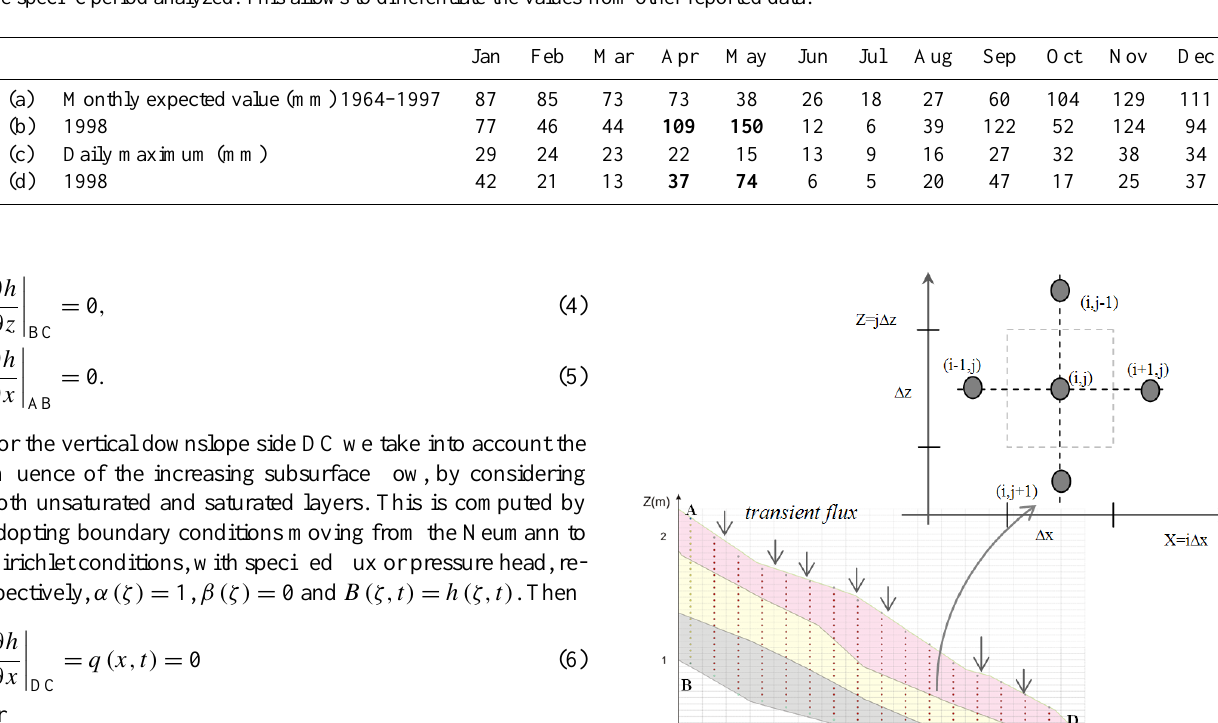
Table 2. Comparison between mean monthly rainfall computed for the period 1964–1997 and the year 1998 (rows a–b); and between maximum daily rainfall for the period 1964–1997 and the year 1998 (rows c–d). Some values are in bold because they reflect the situation of the specific period analyzed. This allows to differentiate the values from other reported data.